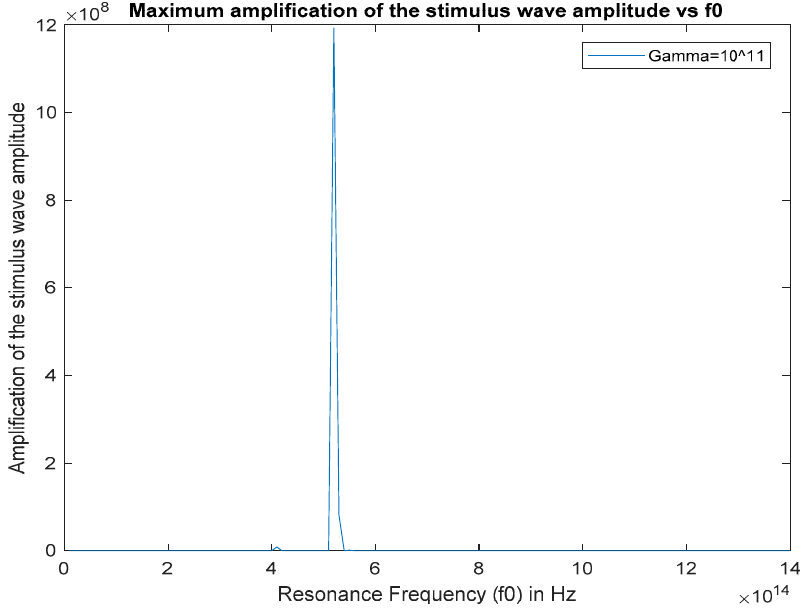
Figure 8. Maximum stimulus wave amplitude (gain factor) inside the cavity at x = 5.73 µ m for 0 < t < 30 ps, γ = 1 × 10 10 Hz, versus f 0 .